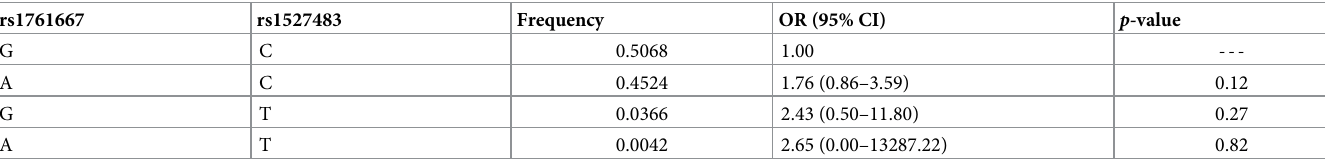
Table 5. Haplotype association with T2DM based on "SNPStats" analysis